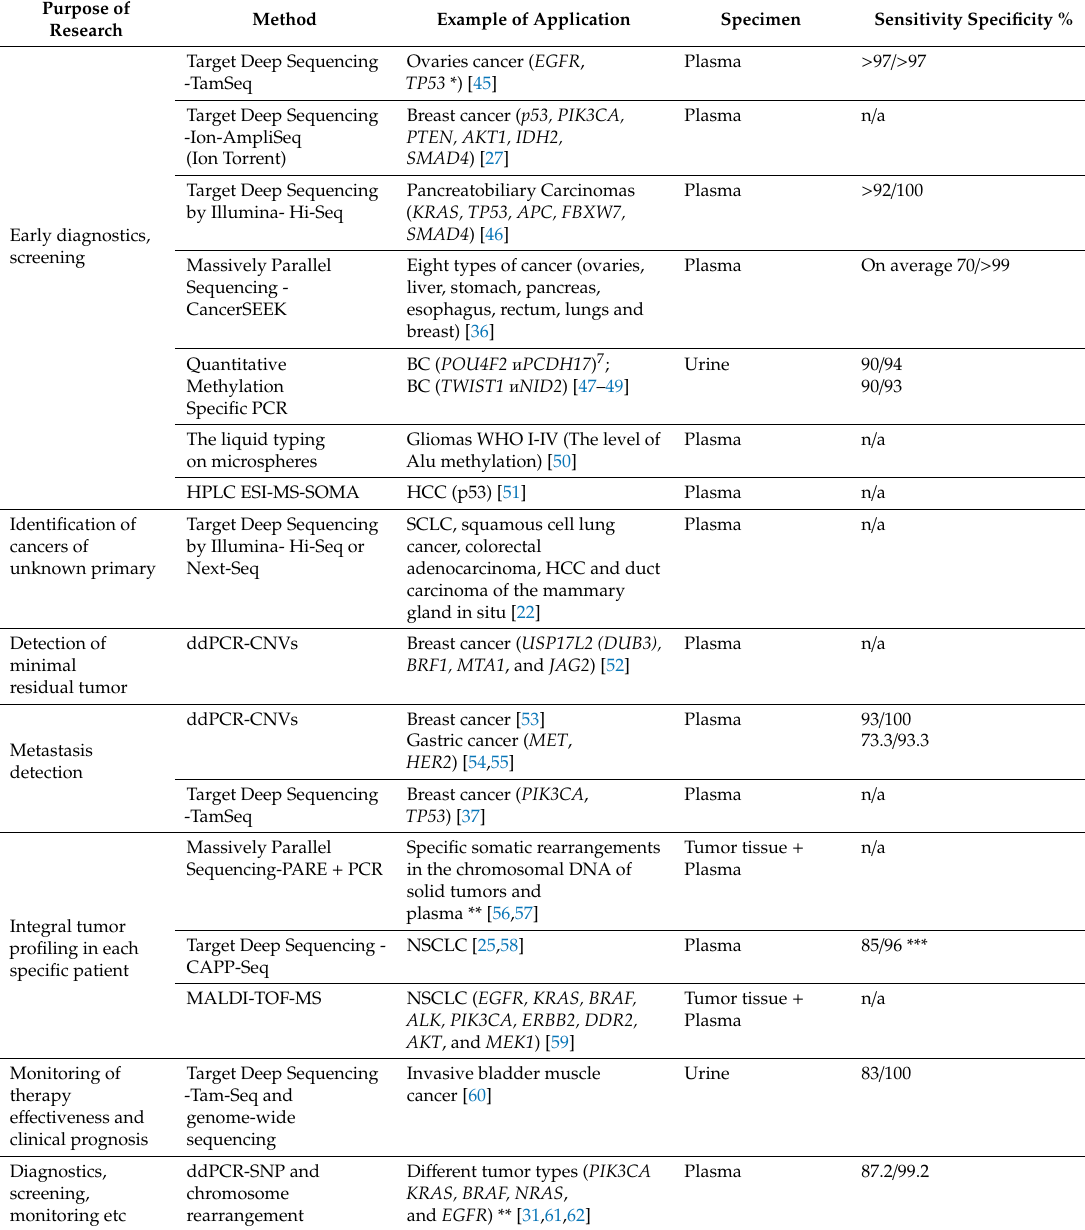
Table 2. Tumor circulating DNA blood tests in personalized cancer diagnostics and cancer